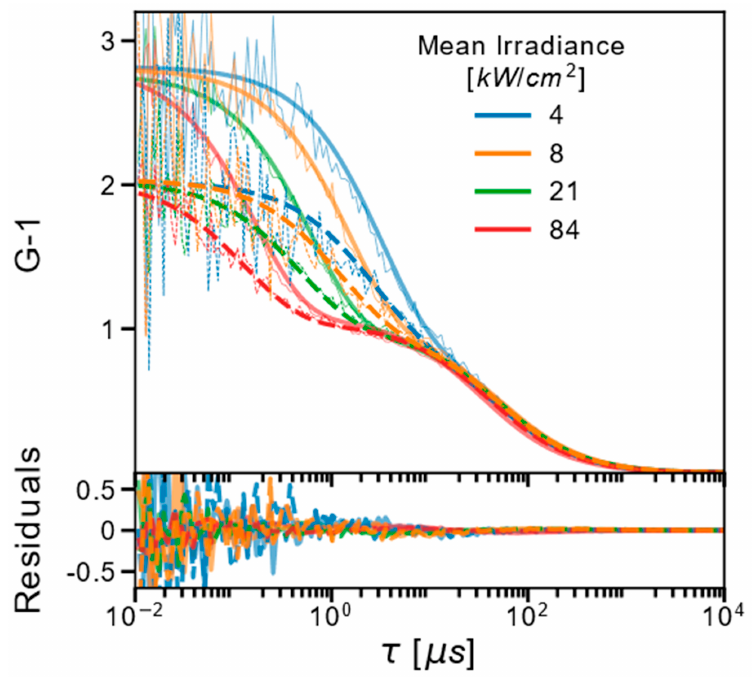
Figure 2. FCS curves recorded under different mean Φ exc (638 nm excitation) and using two different emission filters: 645–680 nm (B ‐ filter, data: thin solid lines; fitted curves: dim thick lines) and 690–750 nm (R ‐ filter, data: dotted lines; fit: thick dashed lines). The FCS curves were fitted globally, as described in the main text. Fitting residuals are shown in the lower subplot.